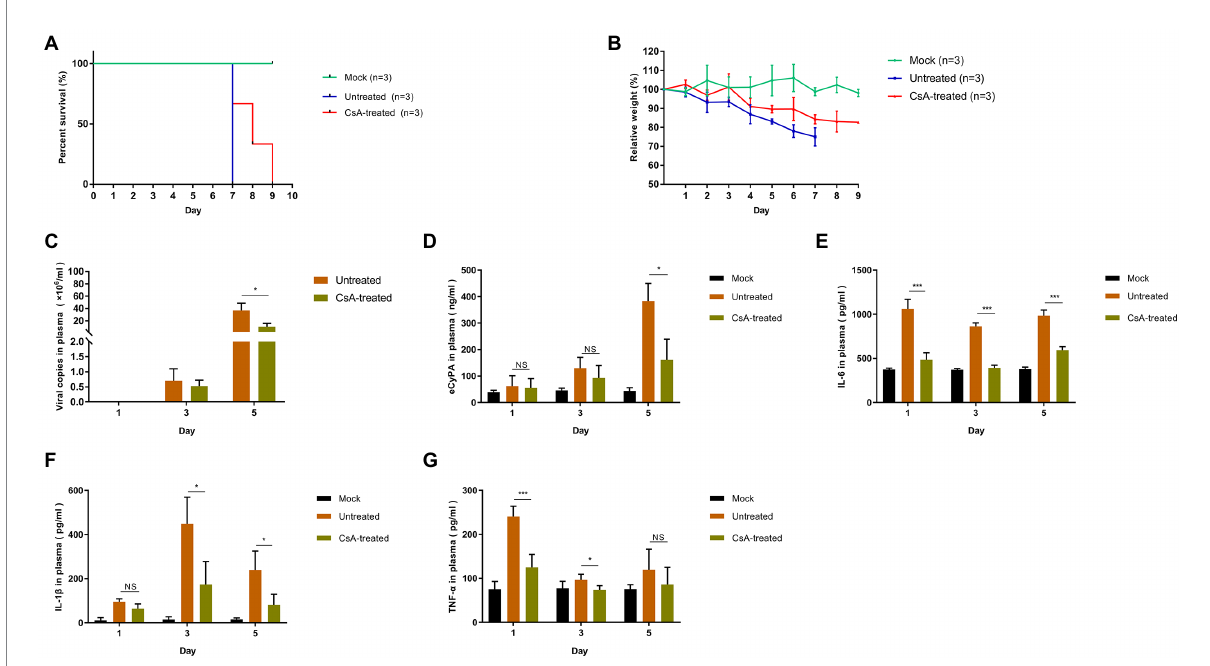
FIGURE 5 Treatment of SFTSV-infected IFNAR − / − mice with CsA. (A) Mice in untreated and CsA-treated groups were inoculated s.c. with 1.0 × 10 6 TCID 50 of SFTSV, while the mock mice were inoculated s.c. with 100 μ l DMEM. In the CsA-treated group, three mice were treated with 10 mg/kg/day CsA for five consecutive days. Survival curves were determined using GraphPad Prism7. (B) The relative weight is shown as means with standard deviations. (C) SFTSV RNA levels in plasma samples collected at 1,3, or 5 days post-infection as determined by qRT-PCR. (D) The levels of CyPA in plasma samples were detected by ELISA. (E–G) The protein levels of proinflammatory cytokines in plasma samples as detected by ELISA. Significance was determined relative to the untreated group: * p < 0.05, ** p < 0.01, *** p < 0.001, NS, no